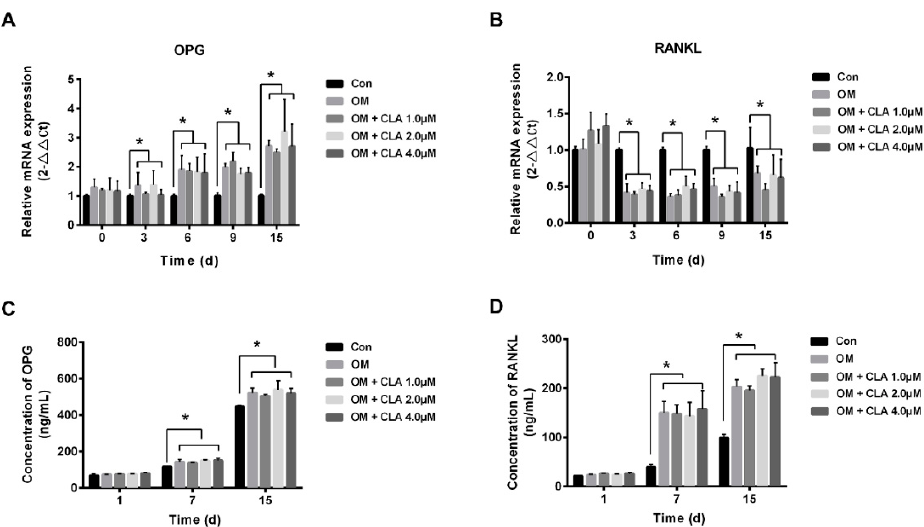
Figure 9. Effect of CLA on OPG/RANKL axis. hBMSCs were maintained in growth medium (Con), or induced for osteogenic differentiation for 1, 3, 6, 9, or 15 d respectively, in the absence (OM) or presence of CLA (CLA). mRNA levels of OPG ( A ) and RANKL ( B ) were measured by RT-qPCR and normalized to GAPDH ; protein levels of OPG ( C ) and RANKL ( D ) in culture media were measured using ELISA kits. Data were expressed as mean ± SD ( n = 3). Compared to Con, data were significantly different at * p < 0.05.